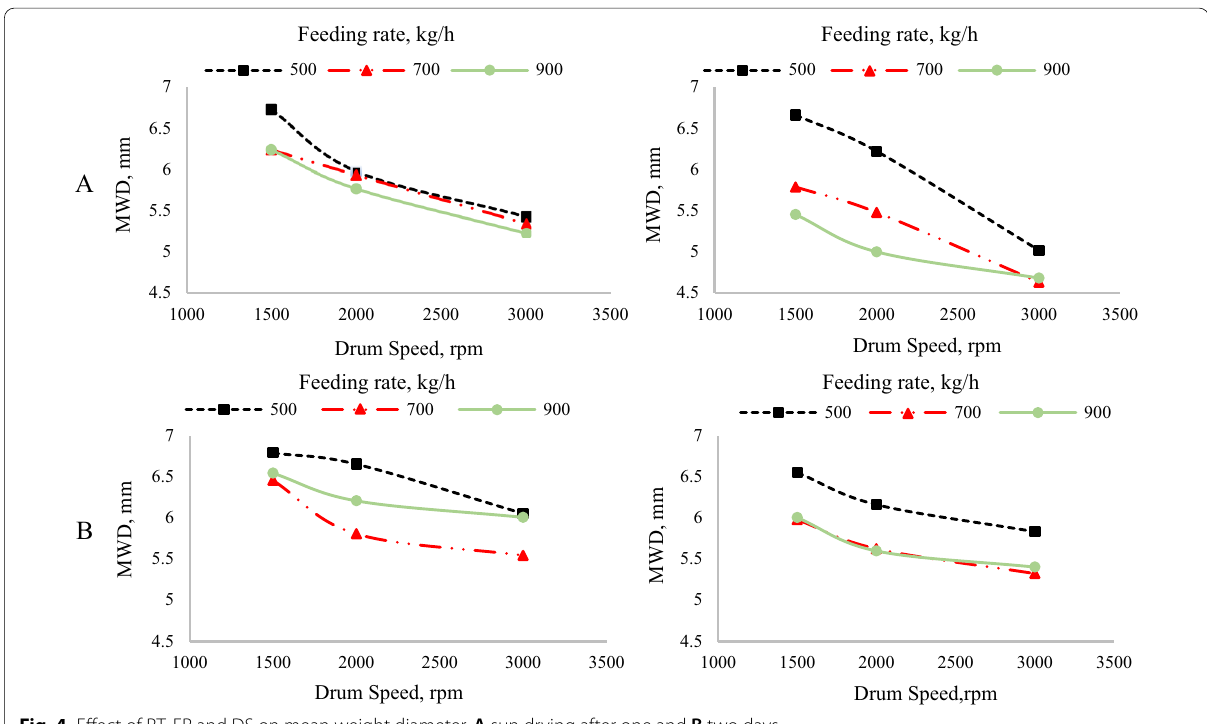
Fig. 4 Effect of RT, FR and DS on mean weight diameter, A sun drying after one and B two